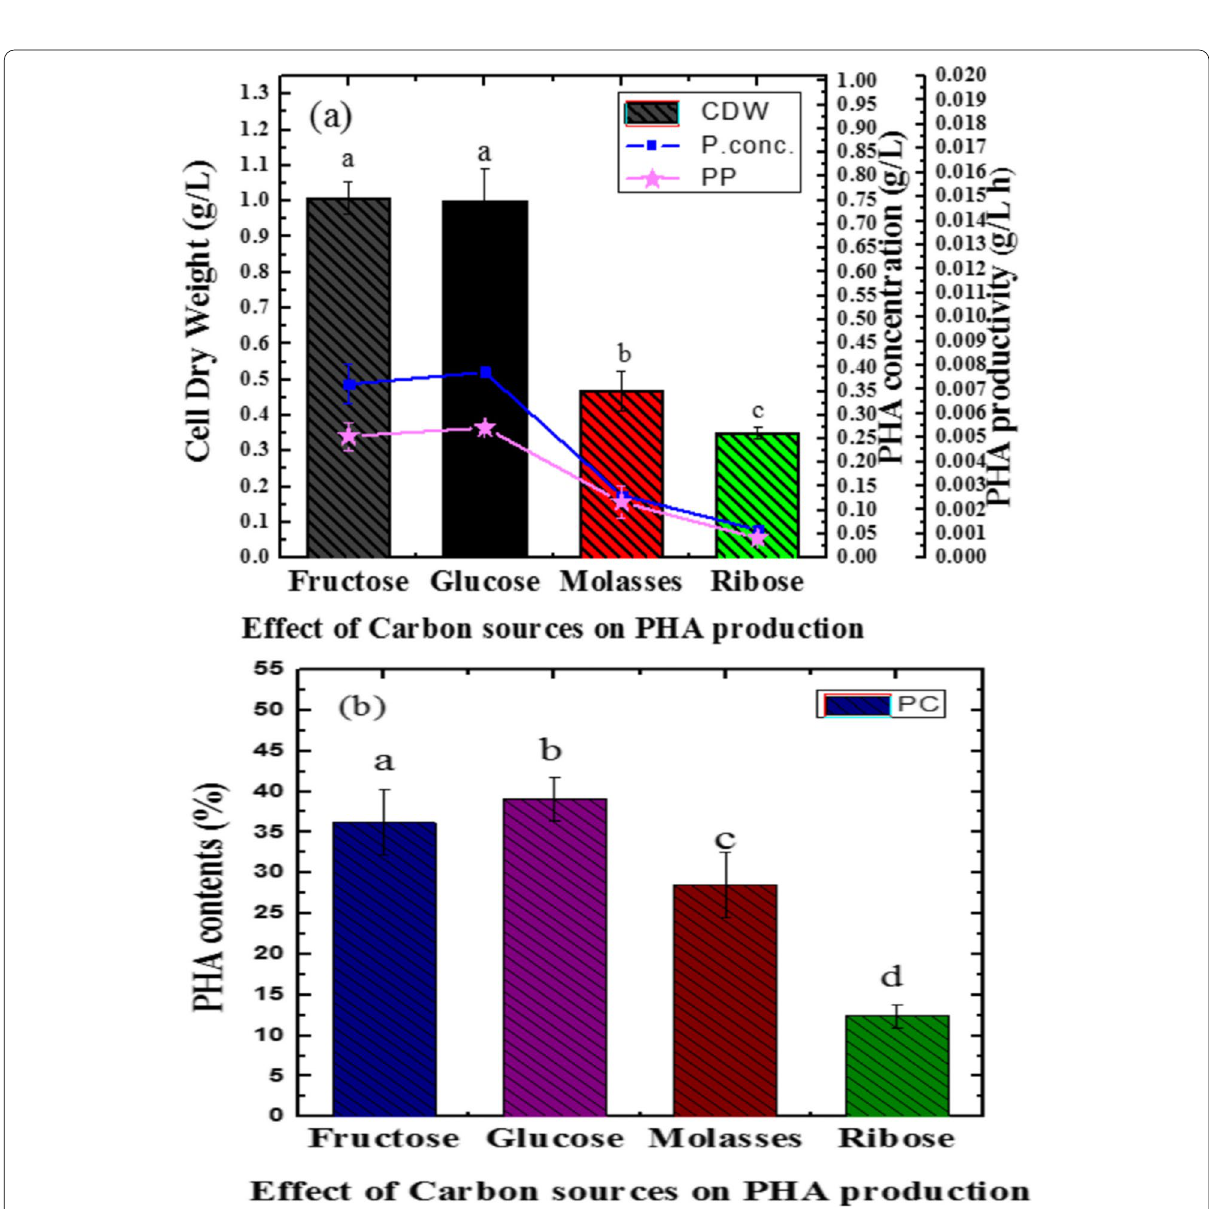
Fig. 7 a Effect of different carbon sources on CDW, P. conc., and PP for newly isolated Bacillus sp. LPPI-18 that are obtained from soil sediment of Loktak Lake. b PCs for 1% fructose, glucose, molasses, and ribose against Bacillus sp LPPI-18 at 37 °C. Data represented the mean replicates ( n 3). One-way ANOVA indicates that the PC has no significant variation ( P =